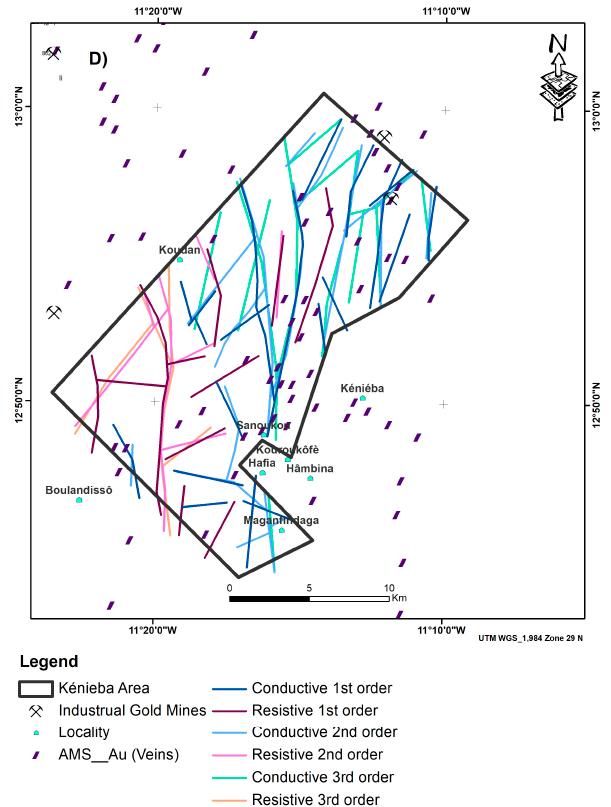
Figure 4. Conductivity: ( A ) first order with mineral occurrences [12], ( B ) second order, ( C ) third order and ( D ) superposition of different interpretation lineaments.